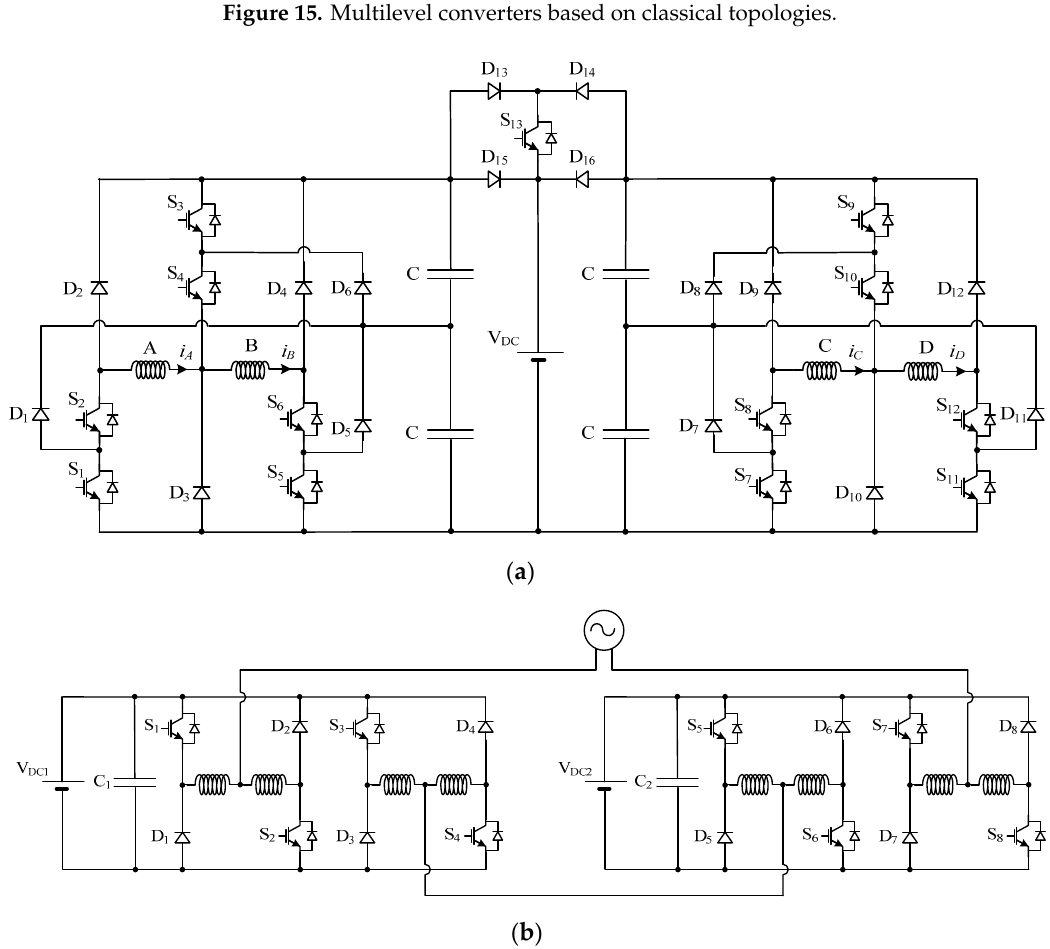
Figure 16. Derived converters from the classical multilevel topologies ( a ) with DC link capacitor voltage boosting ( b ) with a central-tapped node.